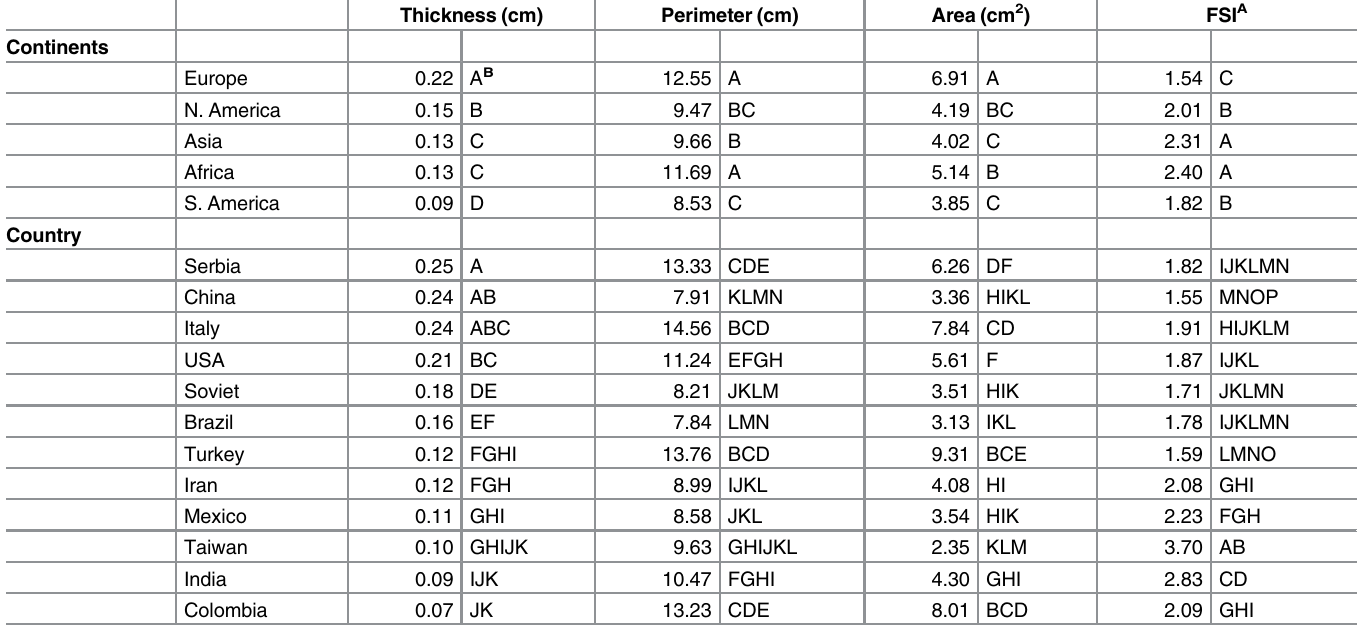
Table 2. Fruit thickness, perimeter, area and fruit shape compared among countries and continents.